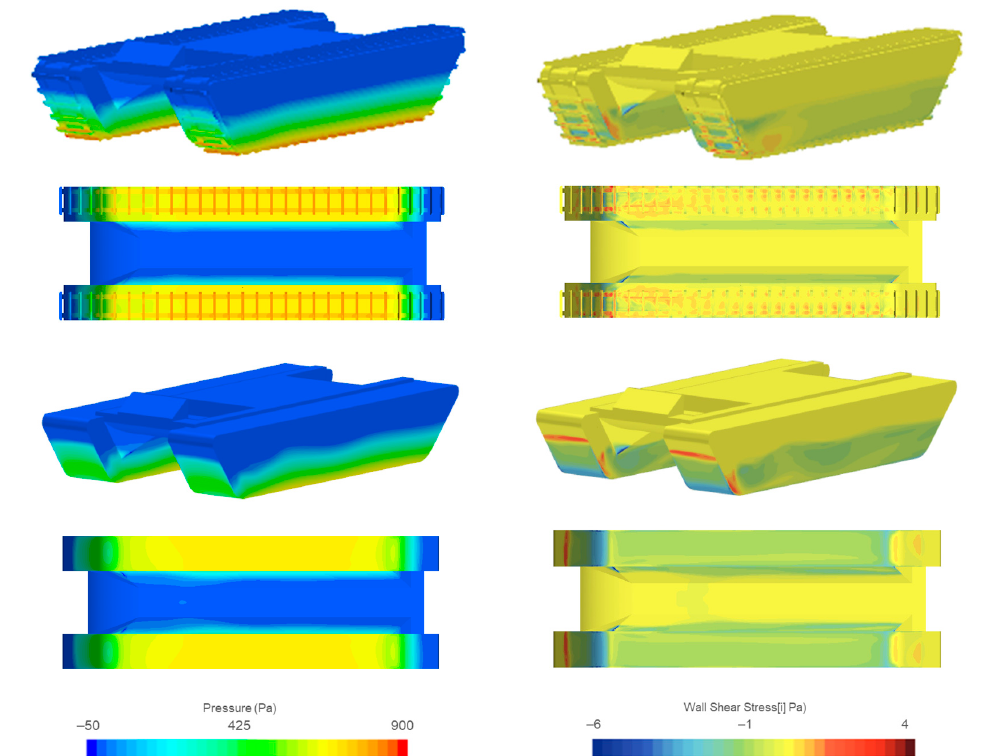
Figure 8. Comparison of pressure and shear stress distribution at Fn = 0.27.